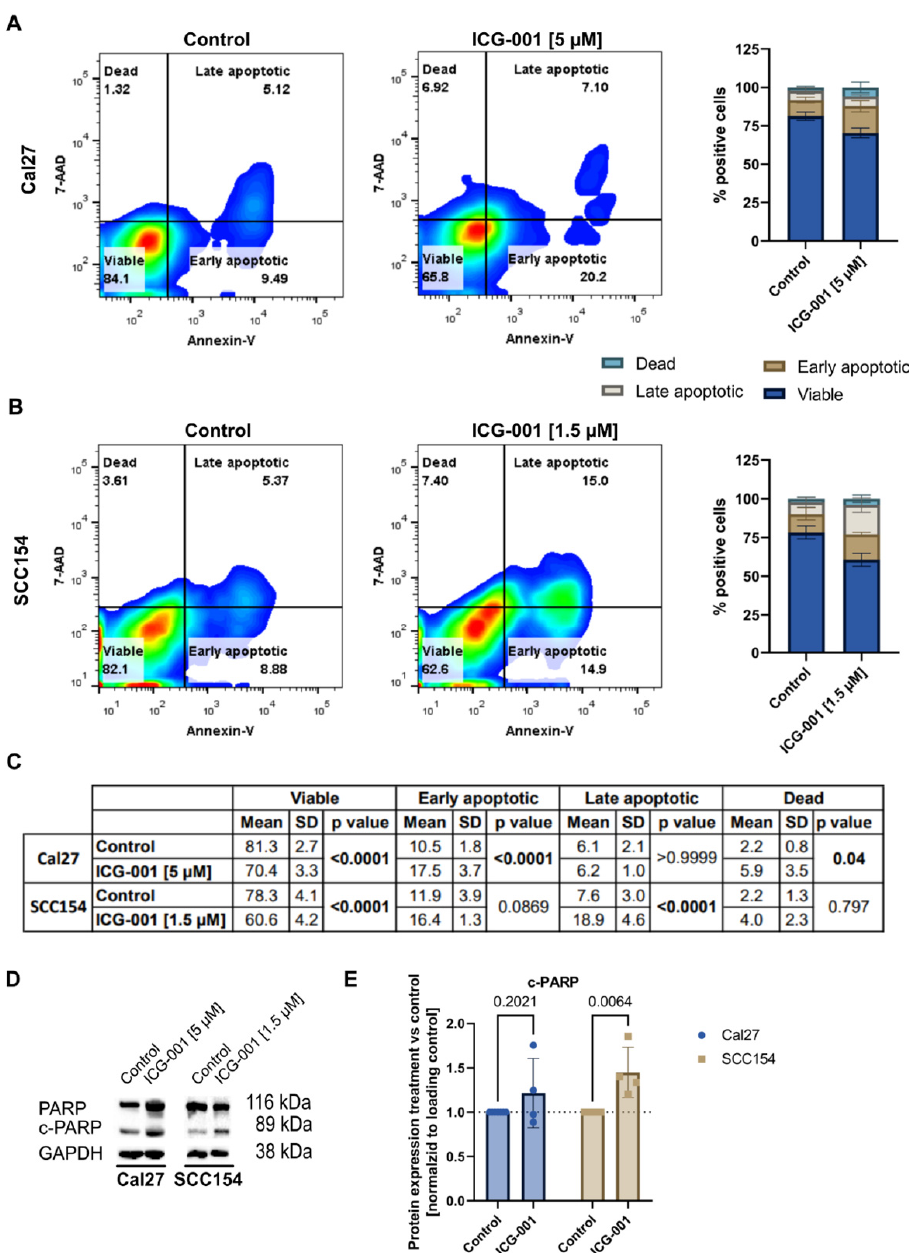
Figure 5. ICG-001 treatment induces apoptosis in HPV-negative and HPV-positive HNSCC cells. ( A ) Representative dot plots of Annexin V/7-AAD assay performed after 72 h of treatment with ICG- 001. One plot each is shown for control (untreated) and ICG-001-treated cells for Cal27 and SCC154, respectively ( A , B ). Proportion of “viable”, “early apoptotic”, “late apoptotic”, and “dead” cells in control and in treated cells was quantified and is shown in the staggered bar plots as mean ± SD ( A , B ). Numeric representation of the quantification of the Annexin V / 7-AAD assay ( C ). Immunoblotting results and quantification for PARP and c-PARP expression in control as well as in ICG-001-treated cells after 72 h of treatment. Bar plots represent mean ± SD ( D , E ). Statistical differences between control and ICG-001-treated cells were assessed using the one-way ANOVA test (Immunoblotting results) and the two-way ANOVA test (Annexin V/7-AAD results). HPV; human papillomavirus, PARP; Poly(ADP-ribose)-Polymerase, SD; standard deviation.